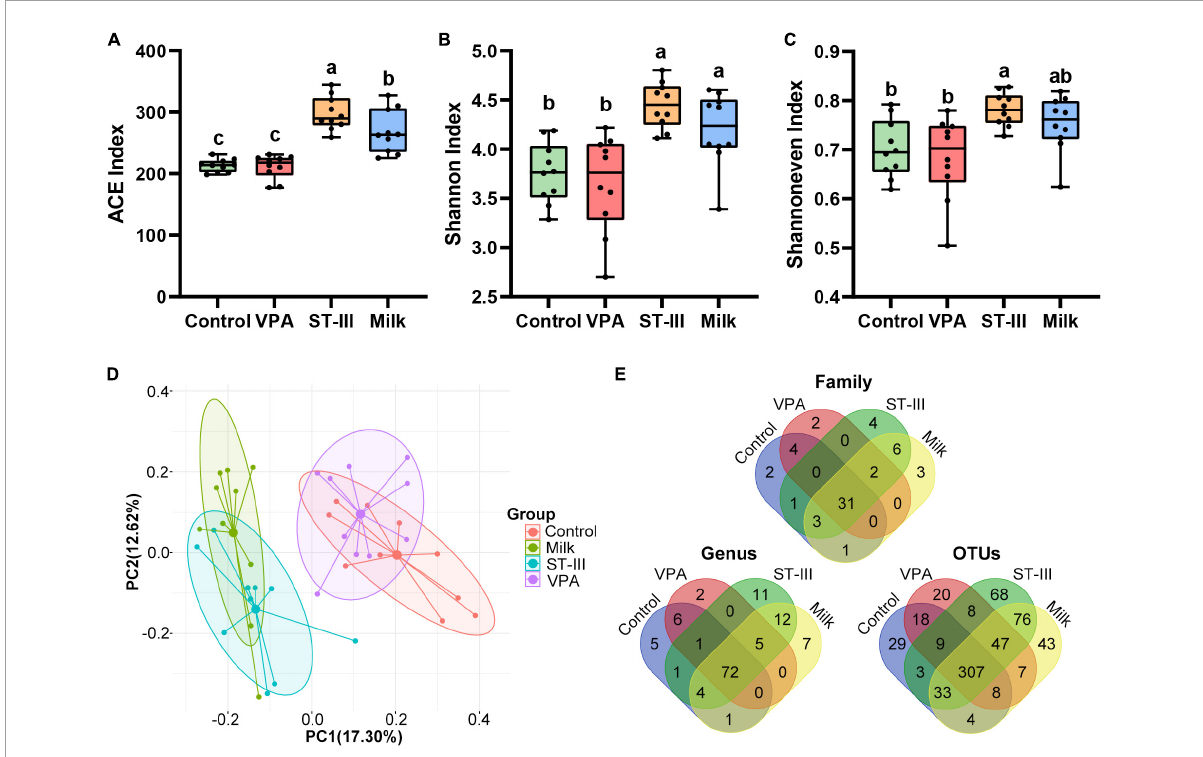
FIGURE2 The effect of milk and Lactiplantibacillus plantarum ST- III -fermented milk on gut microbial diversity in male VPA mice. (A–C) Alpha-diversity in terms of the ACE, Shannoneven and Shannon index. (D) Bray-Curtis distance-based PCoA plot of all OTUs from feces of control, VPA, ST-III and milk group. (E) Venn diagram at family, genus and OUT levels. All data are expressed as mean ± standard deviation, and differences between groups are compared by one-way analysis of variance (ANOVA) with LSD or Duncan post- hoc analysis to correct for multiple comparisons. Differences were considered statistically significant when the p < 0.05. (a–c) Different superscript letters indicate statistically significant differences, and same superscript letters indicate statistically insignificant differences. n = 10 per